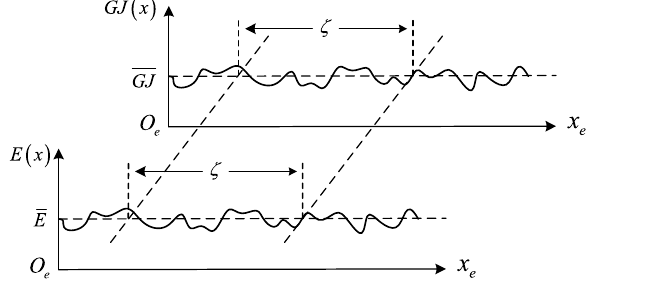
Figure 3. Random